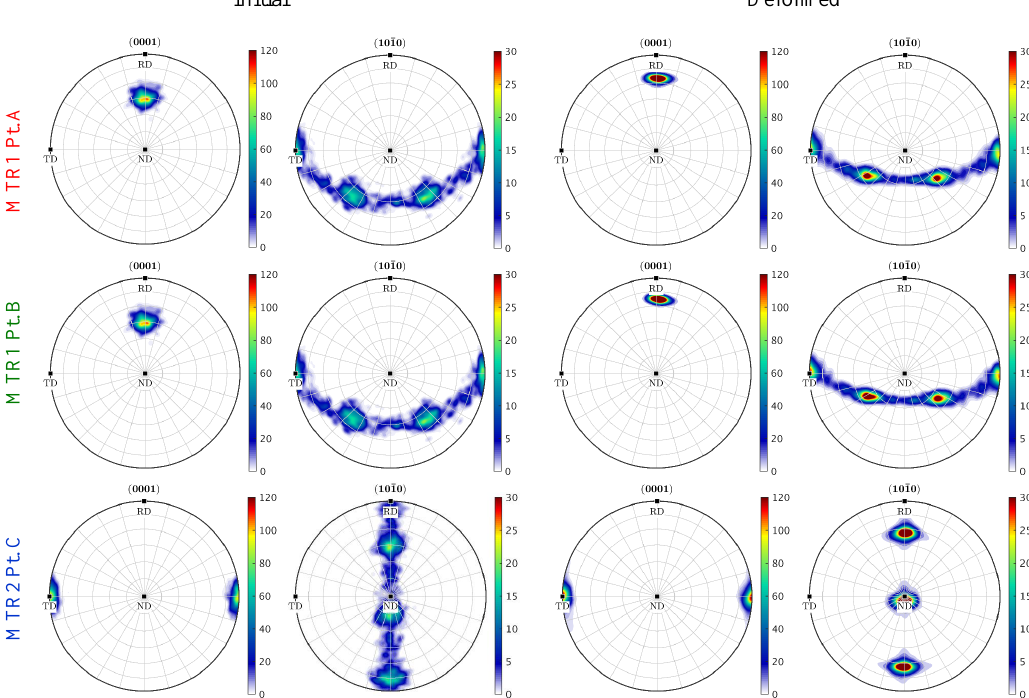
Figure 9. Microscale texture development during 45 ◦ compression simulation. Texture components sharpen in both MTRs, and bulk rotation of texture components is